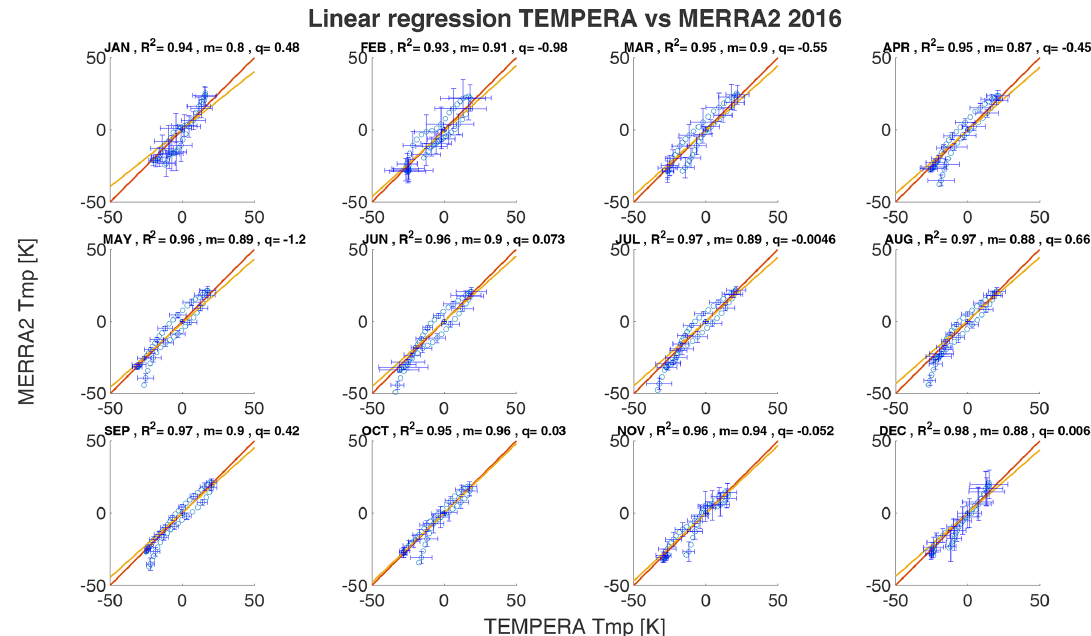
Figure 6. Linear regression of TEMPERA against MERRA2 temperatures.